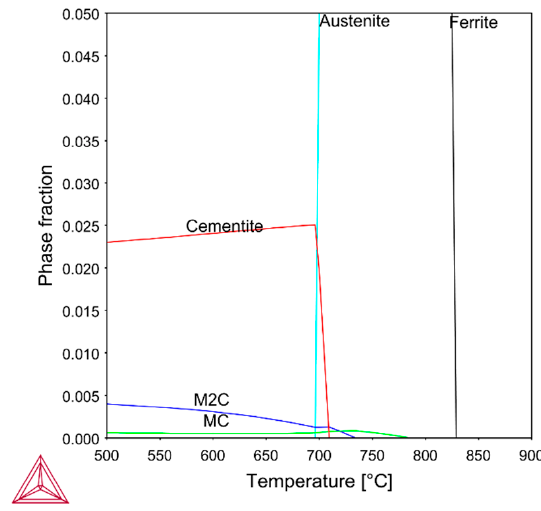
Figure 10. Equilibrium calculation for the nominal composition, based on the TCFE9 database with Thermo-Calc. Table 3. Calculated composition of carbides at 600 ◦ C using Thermo-Calc, with values given in at%.